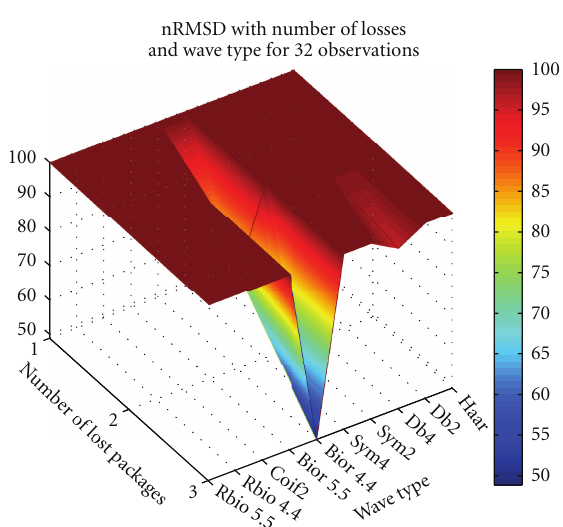
Figure 3: Depiction of SNR and M influence in the nRMSD of the ECG waveform reconstruction, for Daubechies 4 wavelet transform and τ coe ff = 0 . 24.